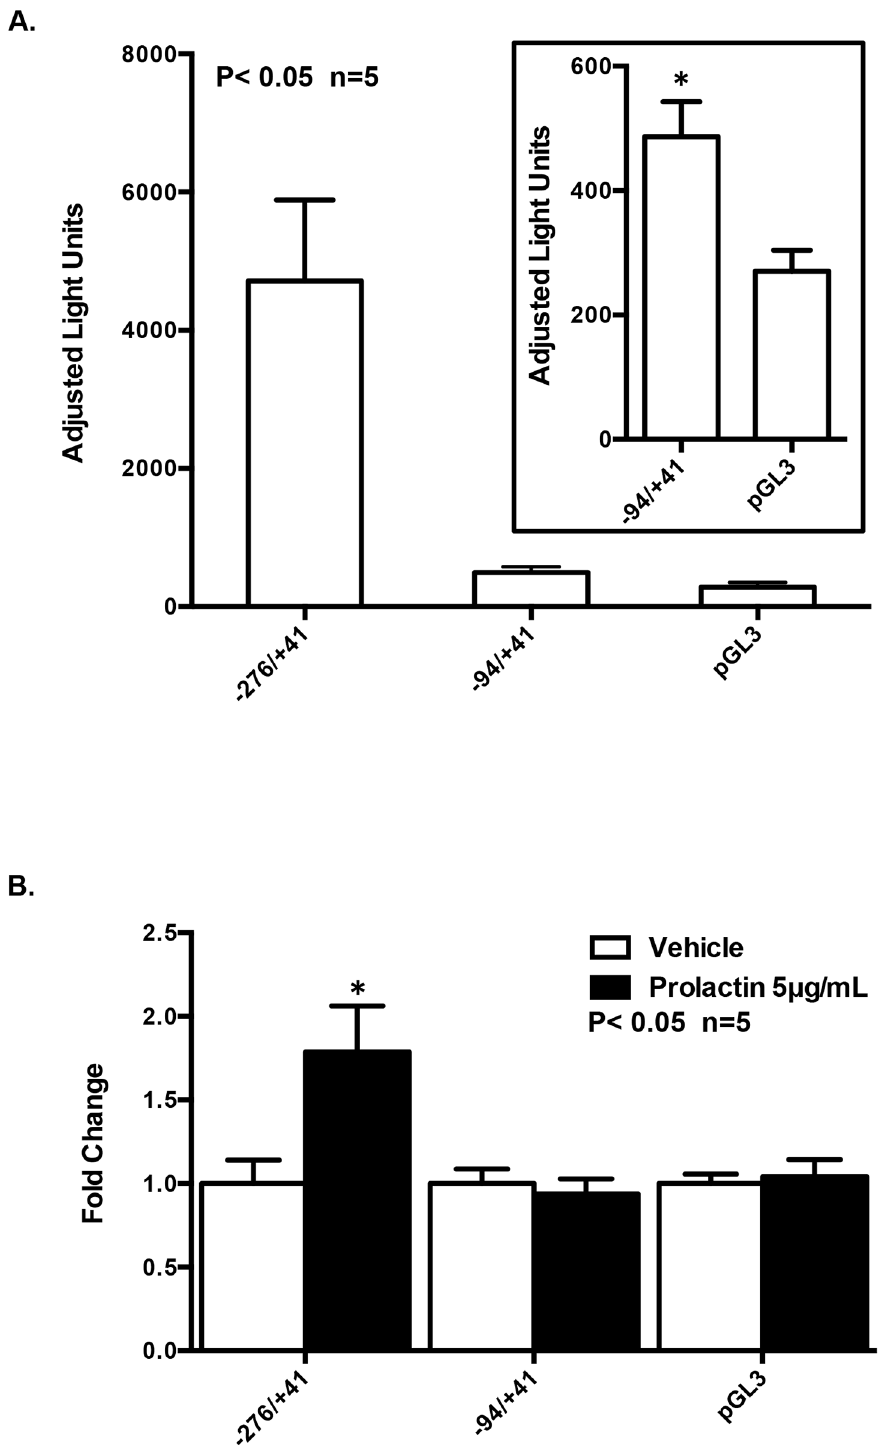
Fig 5. The human PAD3 gene promoter is prolactin responsive in CID-9 cells -276/+41 and -94/+41 base pairs of the human PAD3 gene promoter were cloned from genomic DNA and fused to the cDNA of luciferase. CID-9 cells were transfected overnight with hPAD3 – 276/+41-Luc, hPAD3 – 94/+41-Luc, pGL3 empty, and CMV- β -galactosidase. The next morning cells were treated with vehicle or 5 μ g/mL of prolactin for 24 hours. Cellular lysates were assayed for luciferase and β -galactosidase activity. Luciferase values